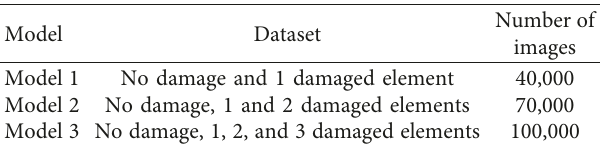
Table 1: Trained